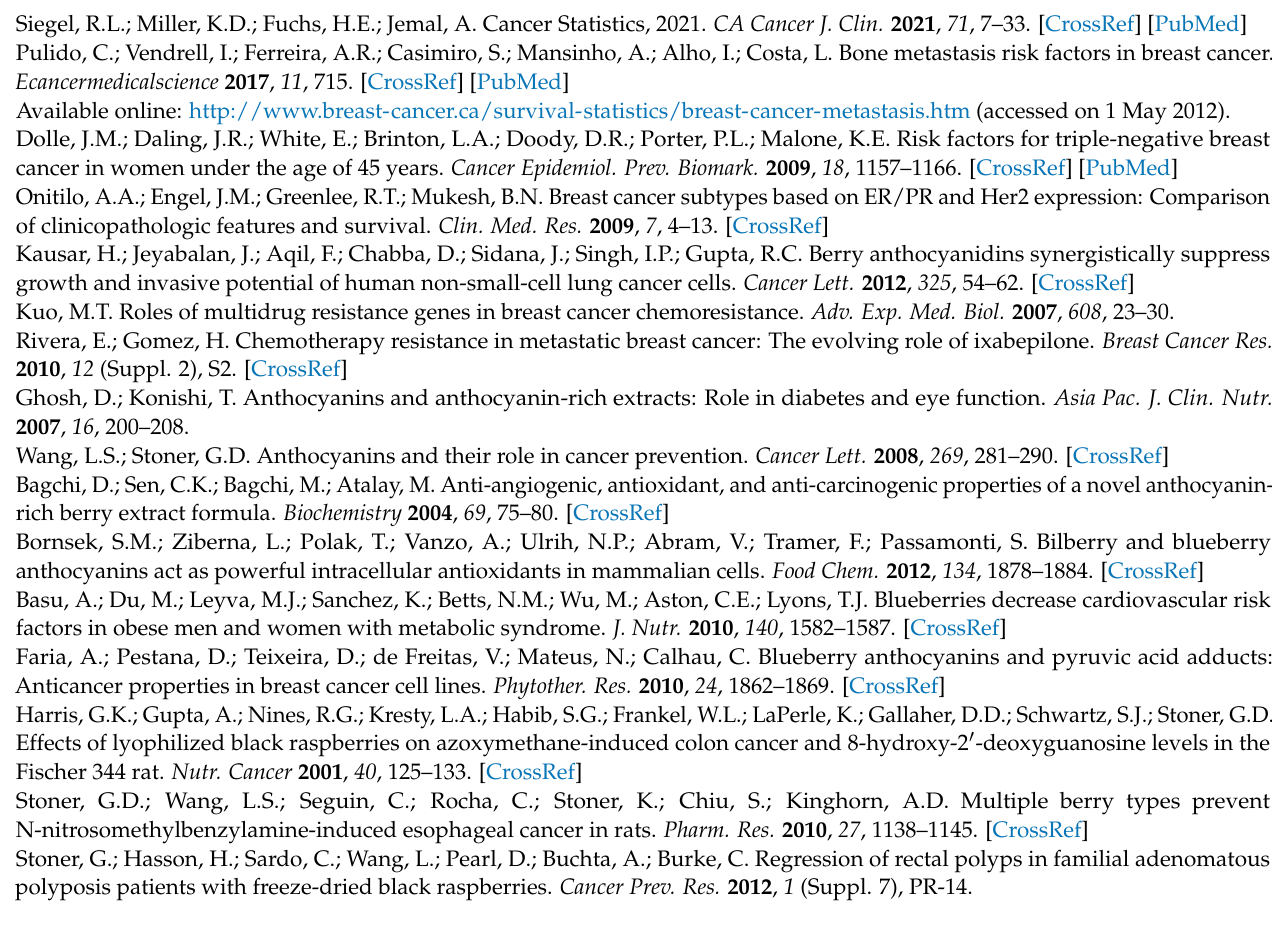
Figure S10: Development of orthotopic models on TNBC in Athymic nude and NOD-skid mice, Figure S11: Anthos inhibits phosphorylation of IkBa dose-dependently in drug-resistant MDA-MB- 231 cells, Figure S12: Densitometry data of blots in Figure 6d, Figure S13: Original Western Blot of Figures 1d, 2e and